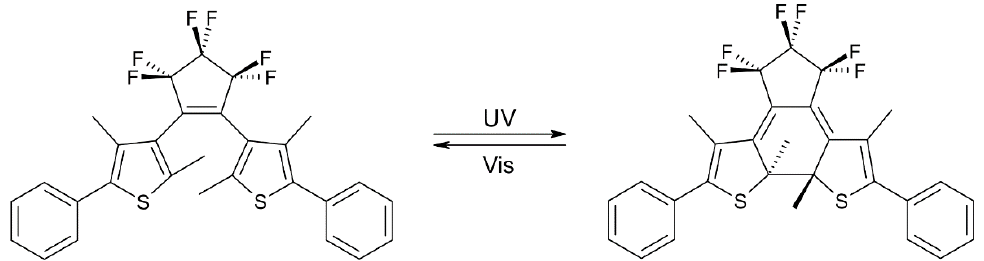
Figure 17. Reversible switching of the model diaryethylene system studied with UED technique by Jean-Ruel et al. [146].